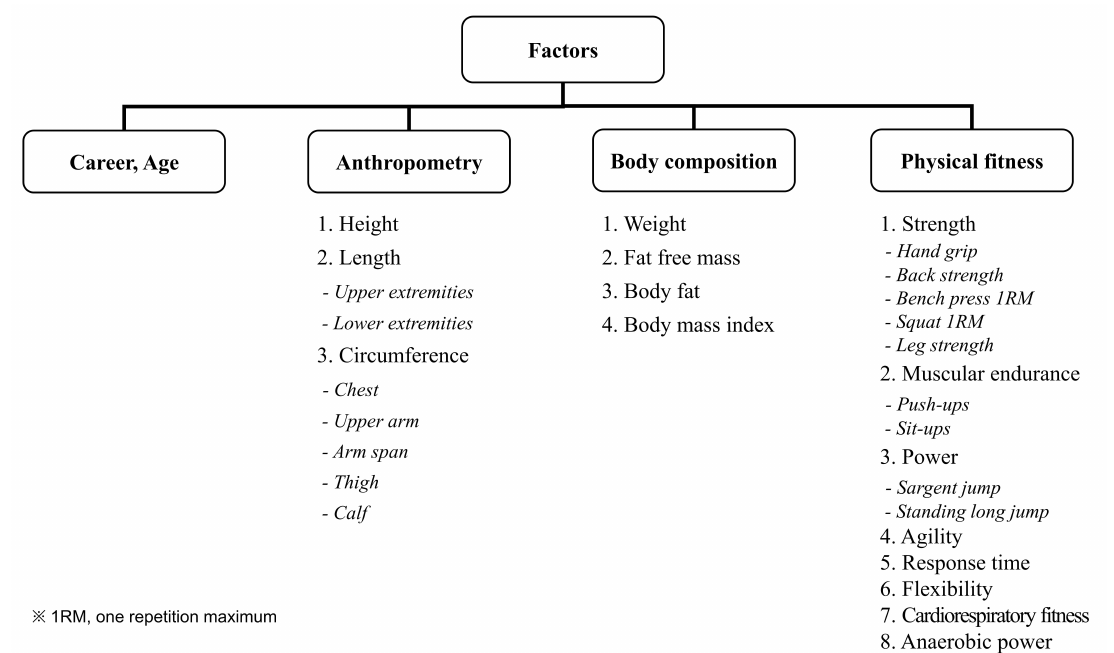
Fig. 1. Factors of the Top Ranker. This figure shows the physical factors considered in this